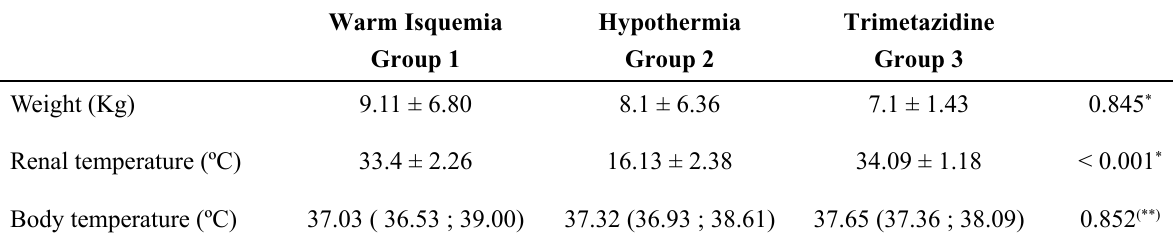
Table 1 - Comparison of weight, renal and body temperature between groups.